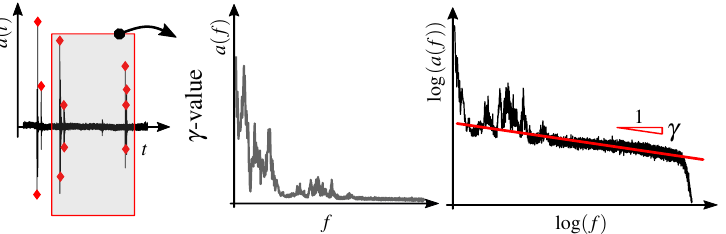
Figure 4. Relation between the power density spectrum and the frequency content, with calculation of the γ